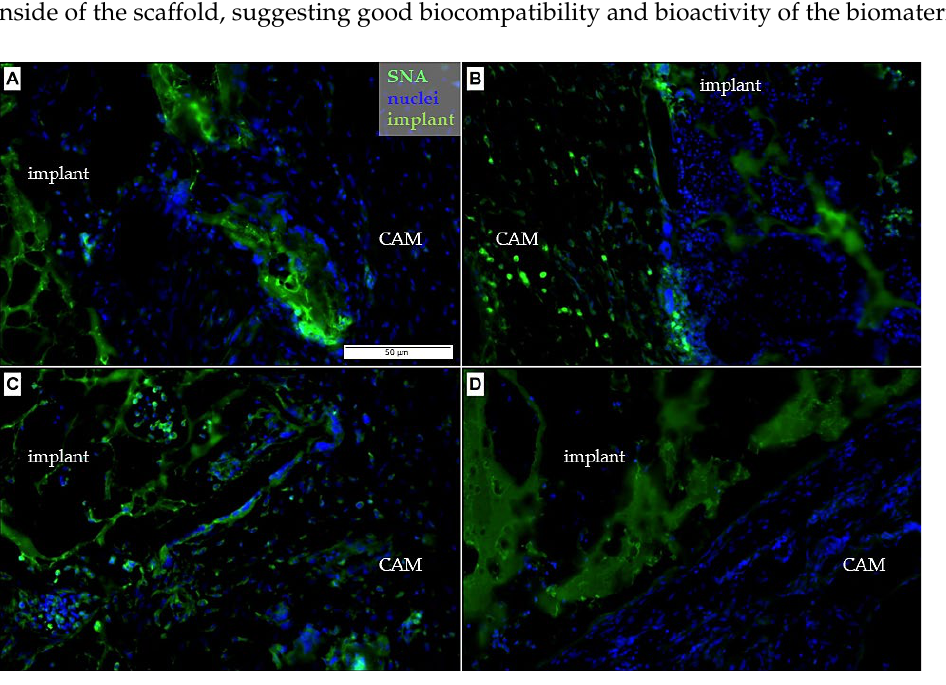
Figure 8. Immunohistochemical detection of the α -smooth muscle actin ( α -SMA) in the porous PHB/CHIT scaffolds. The presence of the myofibroblasts (arrow) was observed on a border between